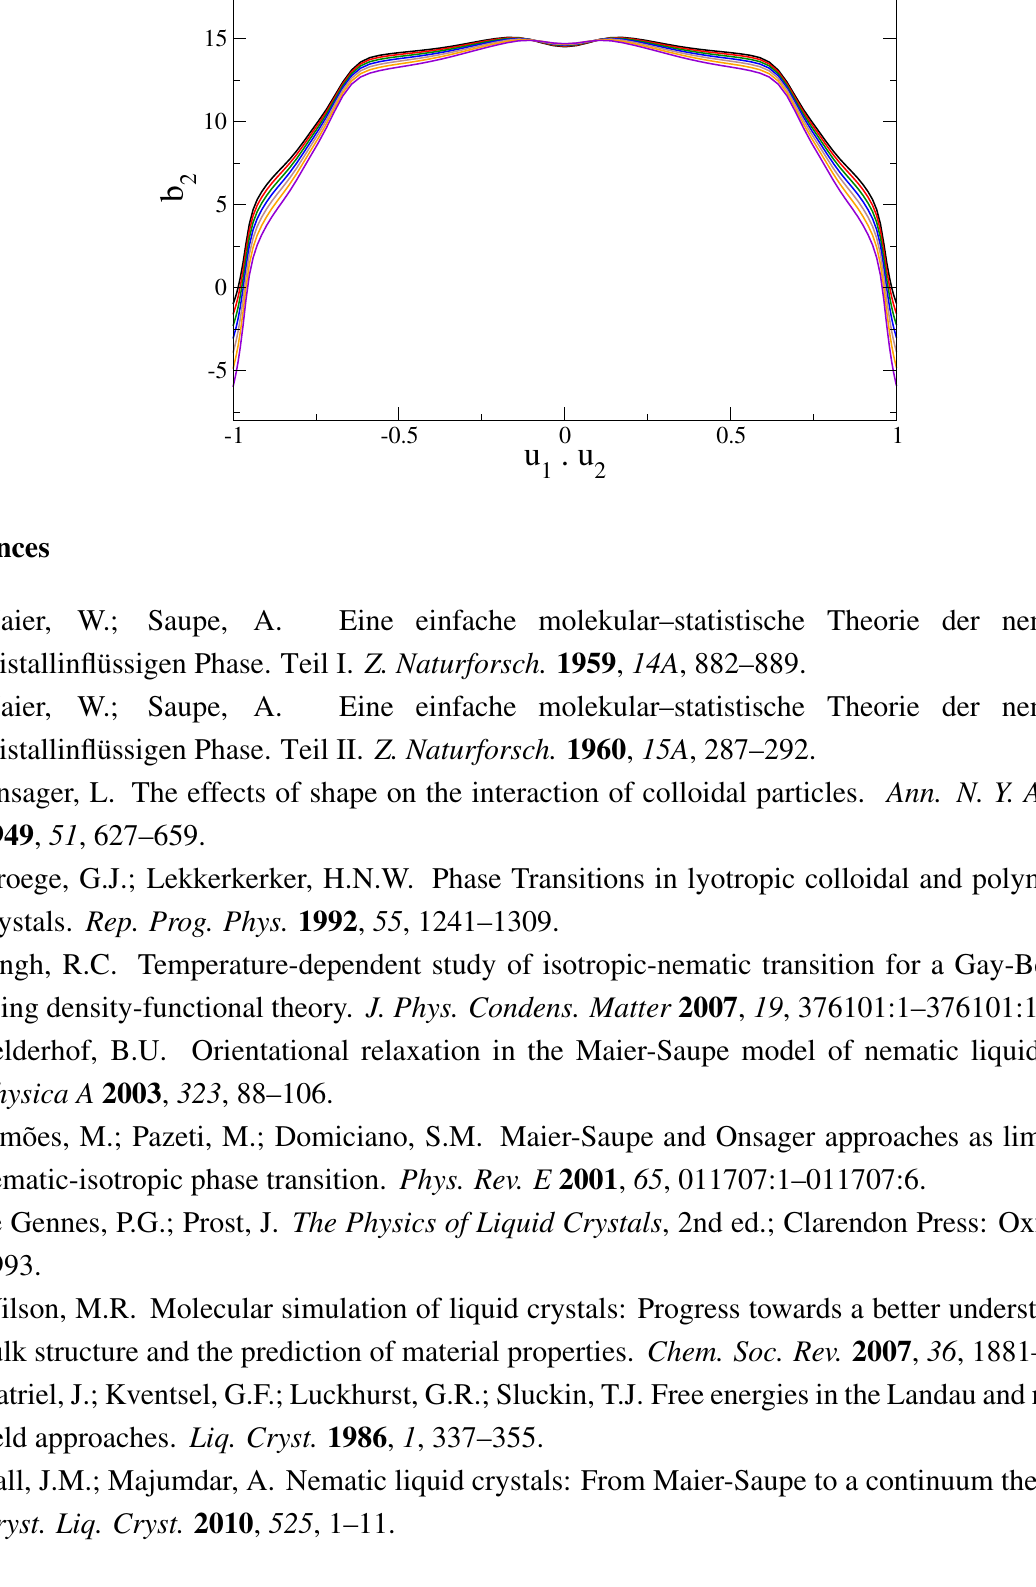
Figure A1. The quantity b defined in the text as a function of the relative orientation of two 2 · u particles, u , for the Gay–Berne model of [30]. The temperature decreases on the right 1 2 from top to bottom as T = 5 . 0 , 4 . 8 , 4 . 6 , 4 . 4 , 4 . 2 , 4 . 0 .